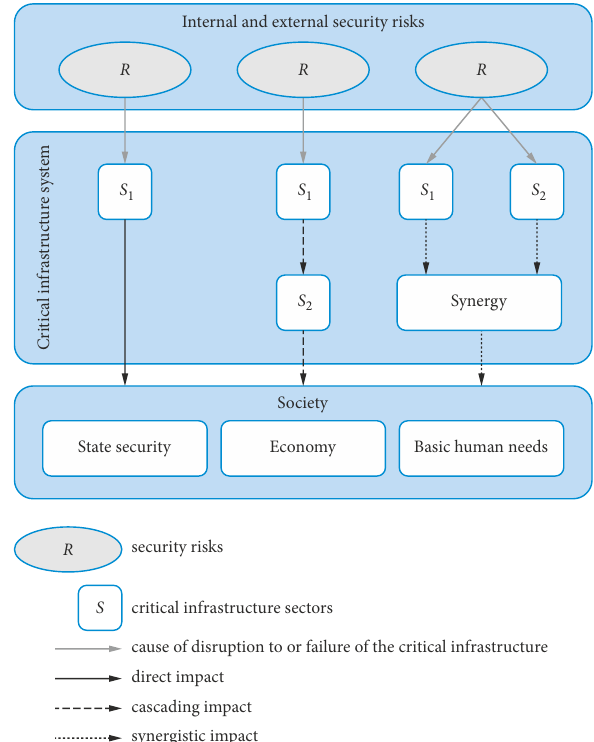
Figure 1. Representation of how effects spread in a critical infrastructure system (Rehak et al. 2018)